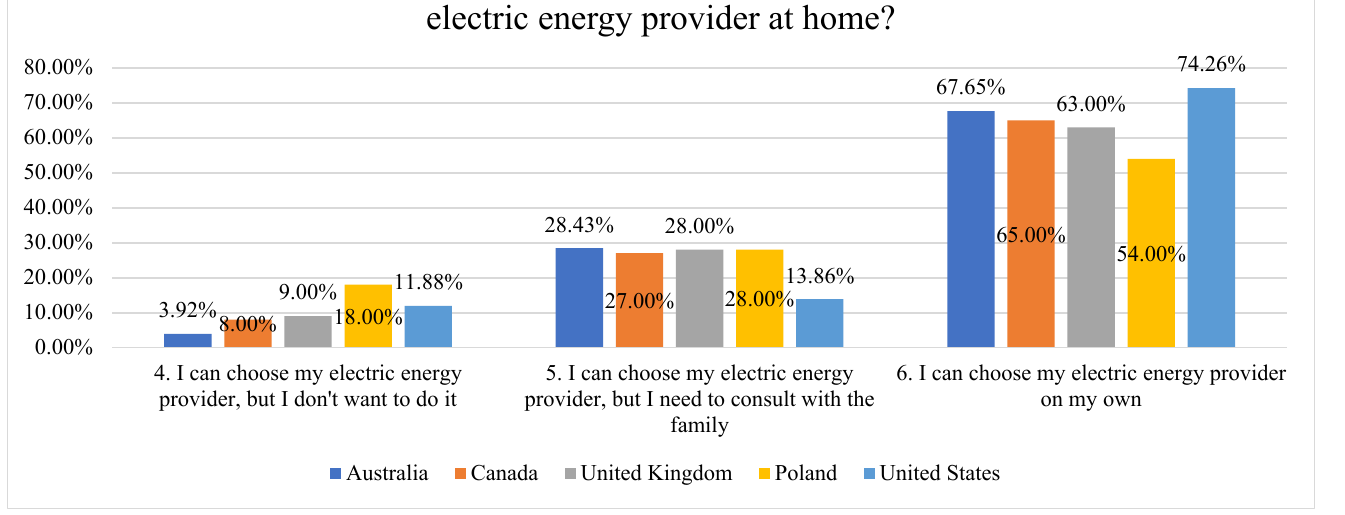
Figure 8. Choosing energy provider status by country . Source: own study.